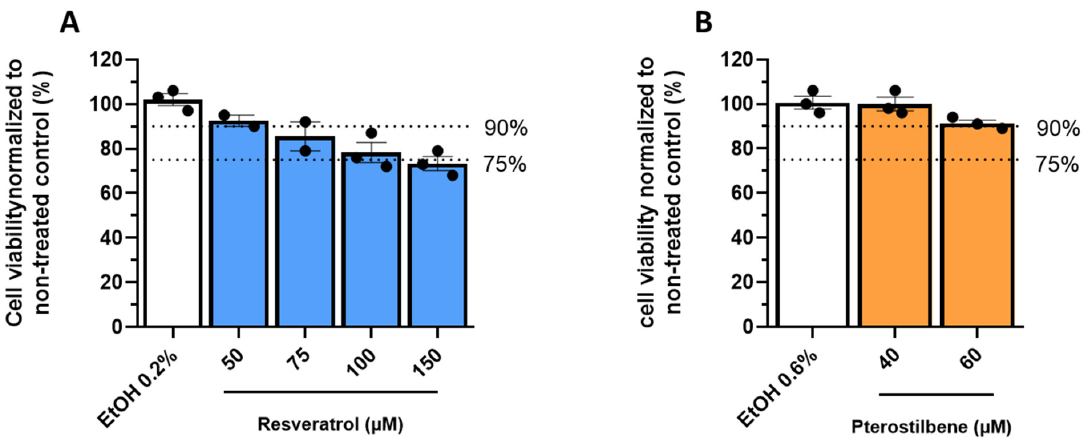
Figure A3. Cellular cytotoxicity of resveratrol and pterostilbene in Calu-3 cells. Calu-3 cells were incubated with increasing concentrations ( A ) resveratrol, ( B ) pterostilbene, or ( A , B ) equivalent volumes of EtOH corresponding to the highest used concentration. Cell viability was assessed using an MTS assay. Cell viability is expressed as percentage compared to non-treated control. Data are represented as mean ± SEM, symbols represent two or three independent experiments each performed in duplicates.